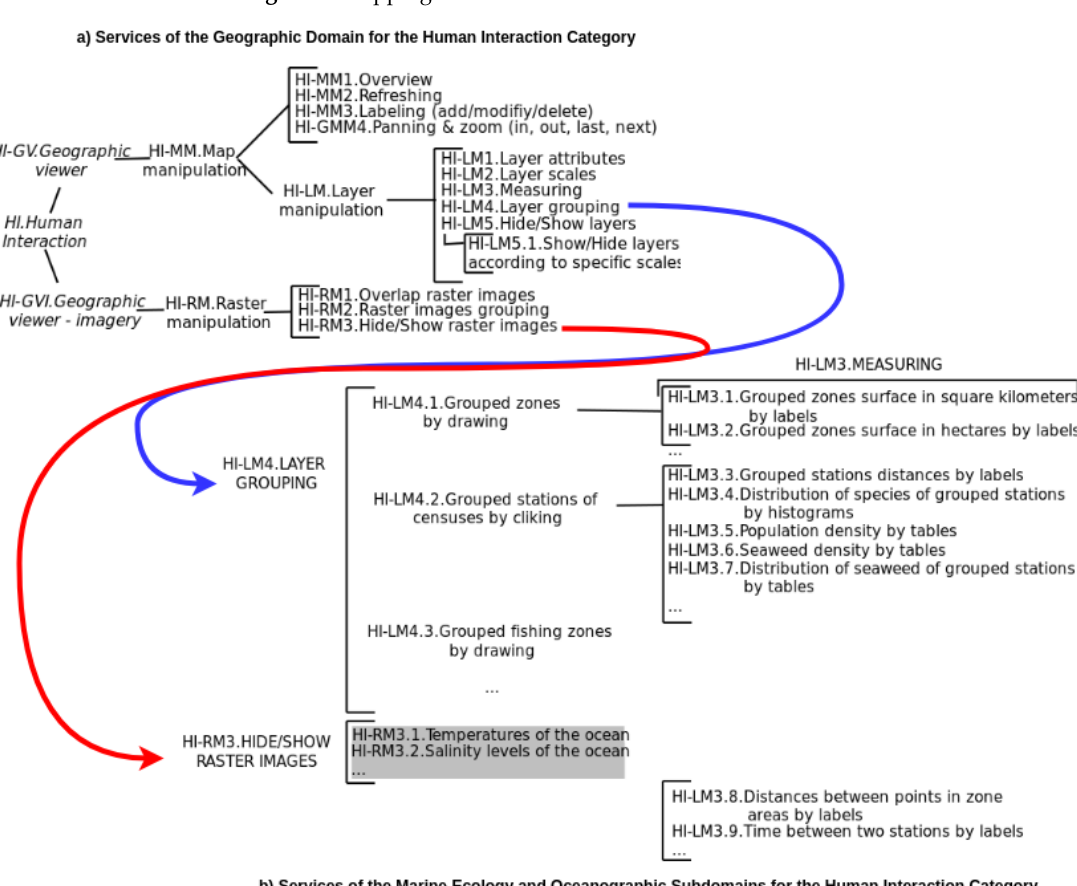
Figure 1. Mapping between ISO 19119 and ISO 19109 stds.